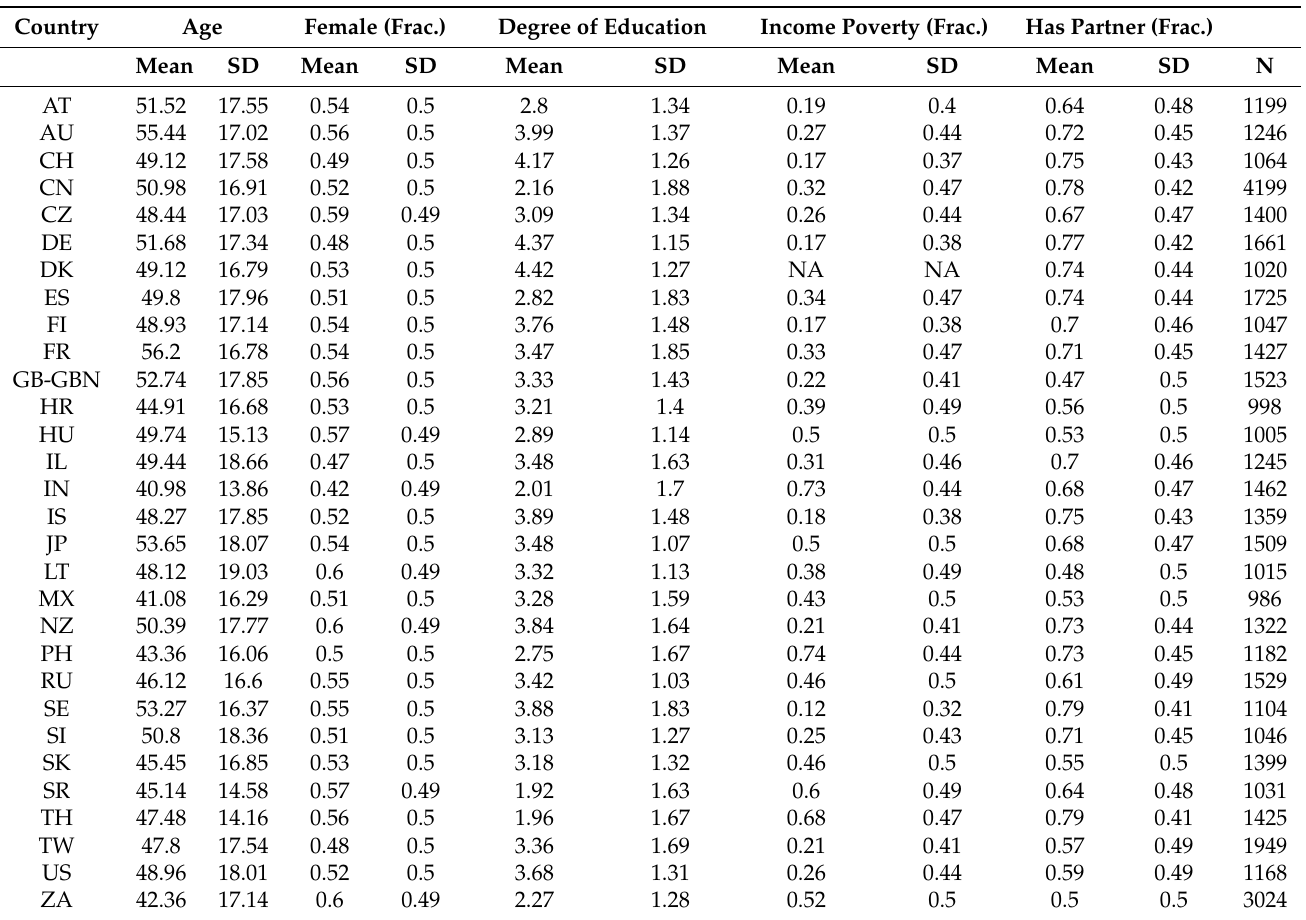
Table A1. Additional country-level descriptive statistics.